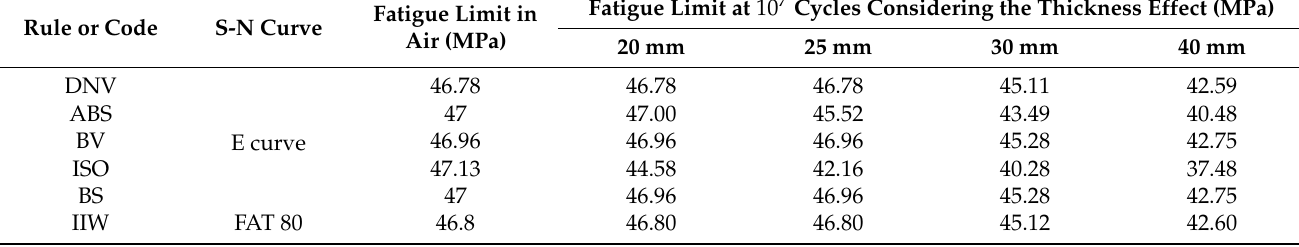
Table 4. Fatigue limits required in the rules and codes.